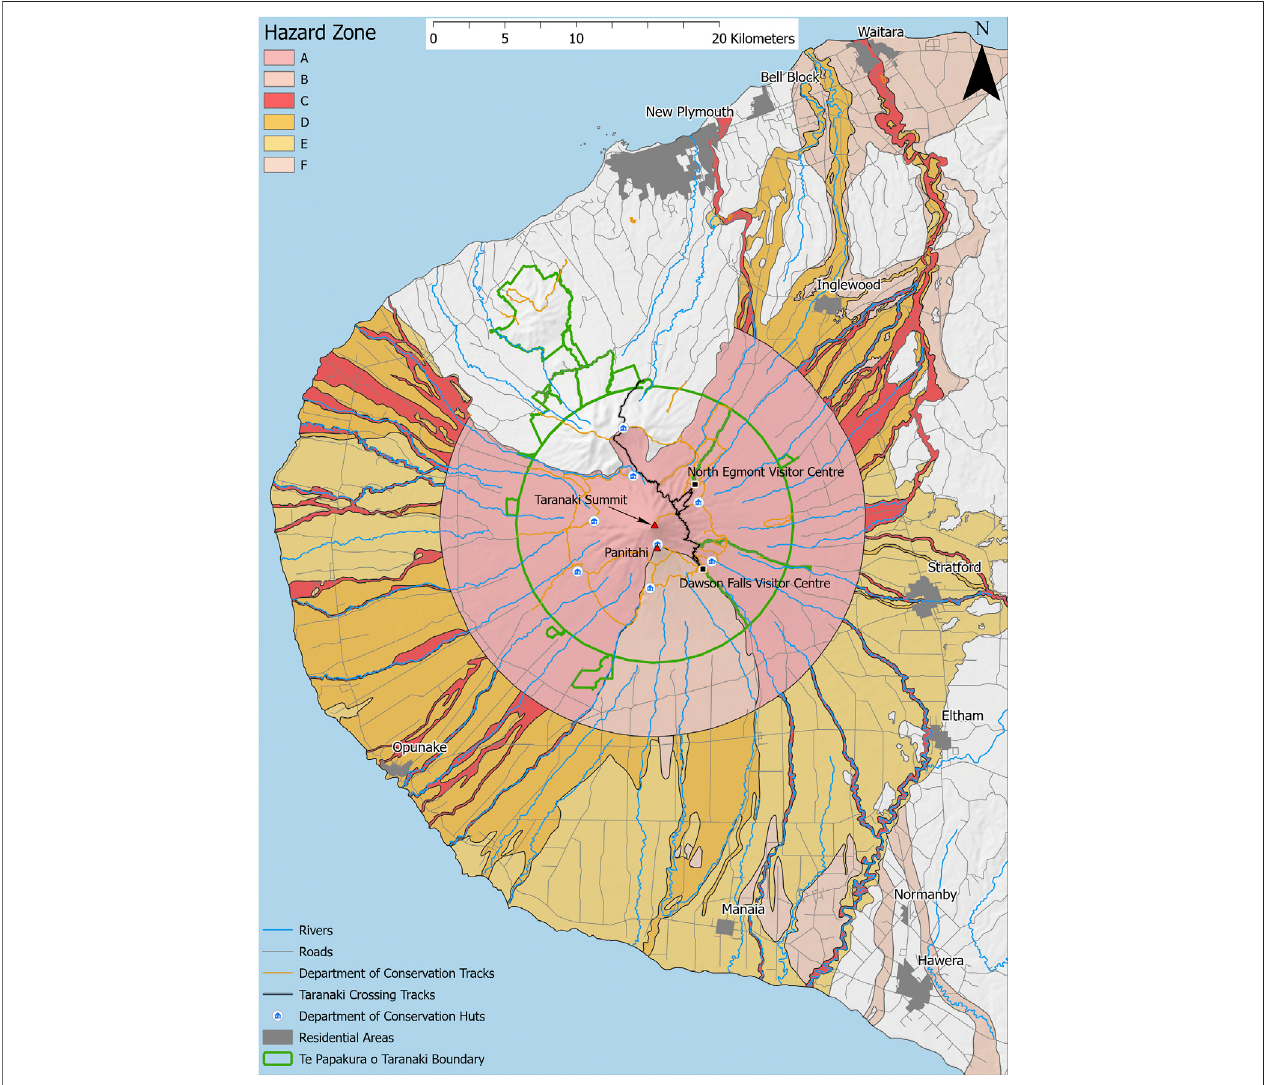
FIGURE 2 | Taranaki volcanic hazard map and zones from Neall and Alloway (1996). Zone (A) is region of highest hazard from Taranaki Summit near-vent effects; (B) is region of highest hazard from Panitahi (Fanthams Peak) near-vent effects; (C) is region of highest hazard from distant effects, including lahars; (D) is region of intermediatehazardfromlaharsandassociated fl oods; (E) isareaaffectedbylargedebrisavalanchesandlahars; (F) isareaaffectedbyrarelargedebrisavalanchesand lahars.